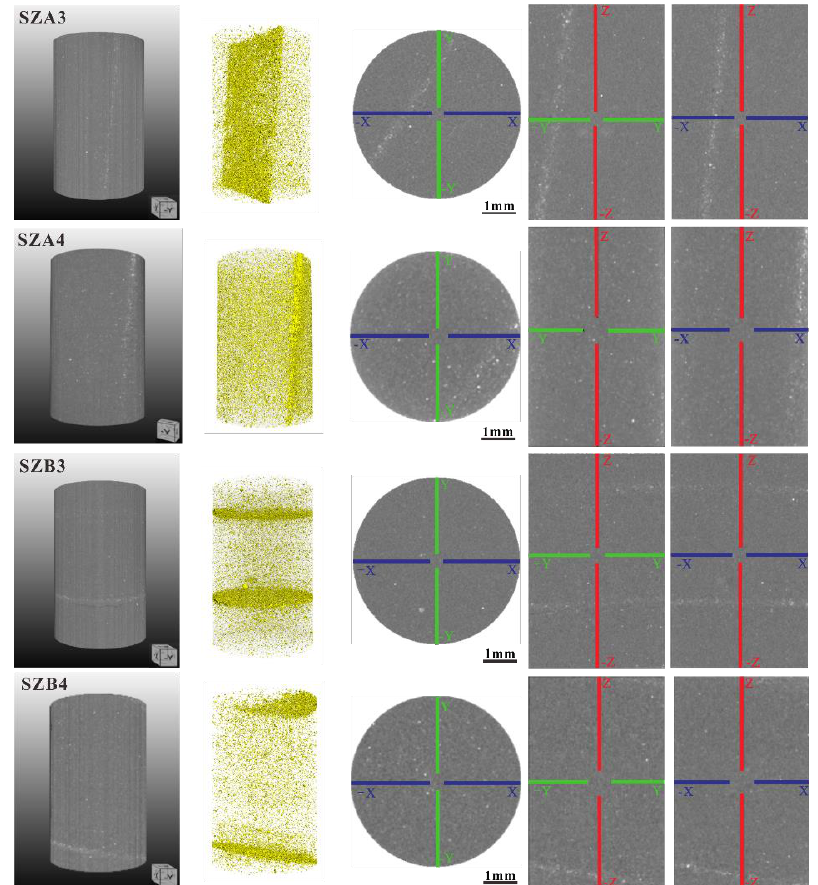
Figure 4. Three dimensional (columns 1–2) and two dimensional (columns 3–5) micro-CT images of specimens SZA3, SZA4 and SZB3, SZB4 before uniaxial compression (X: x-axis, Y: y-axis, Z: z-axis). Bright area denotes high-density substance, and dark area denotes low-density substance. Pyrite is segmented individually in yellow area. The cross-sectional view shows the center slice of the specimen.